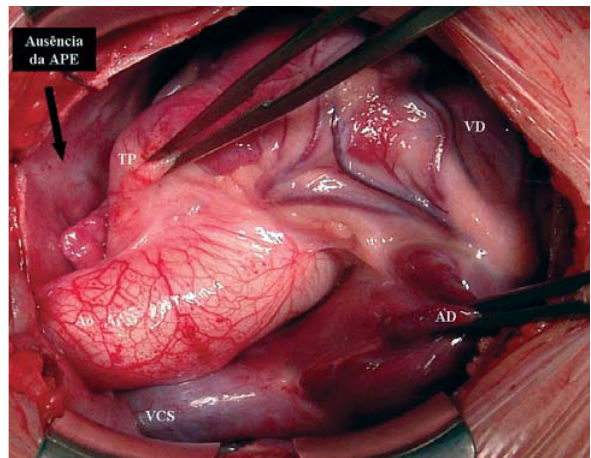
Fig. 4 – Aspecto geral do coração e vasos da base após abertura do saco pericárdico. Fica clara a ausência da artéria